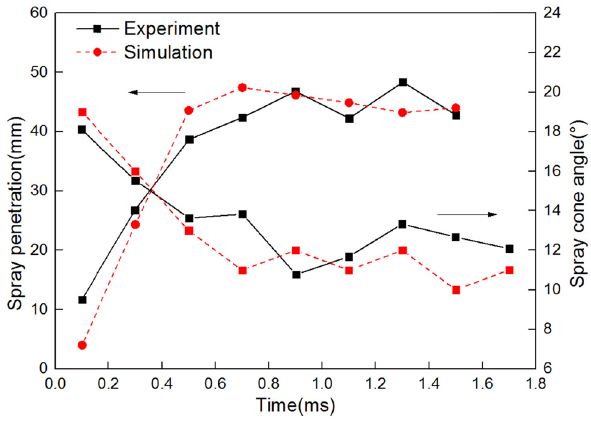
Figure 6: Spray penetrations and spray cone angles from experi - ment and simulation.